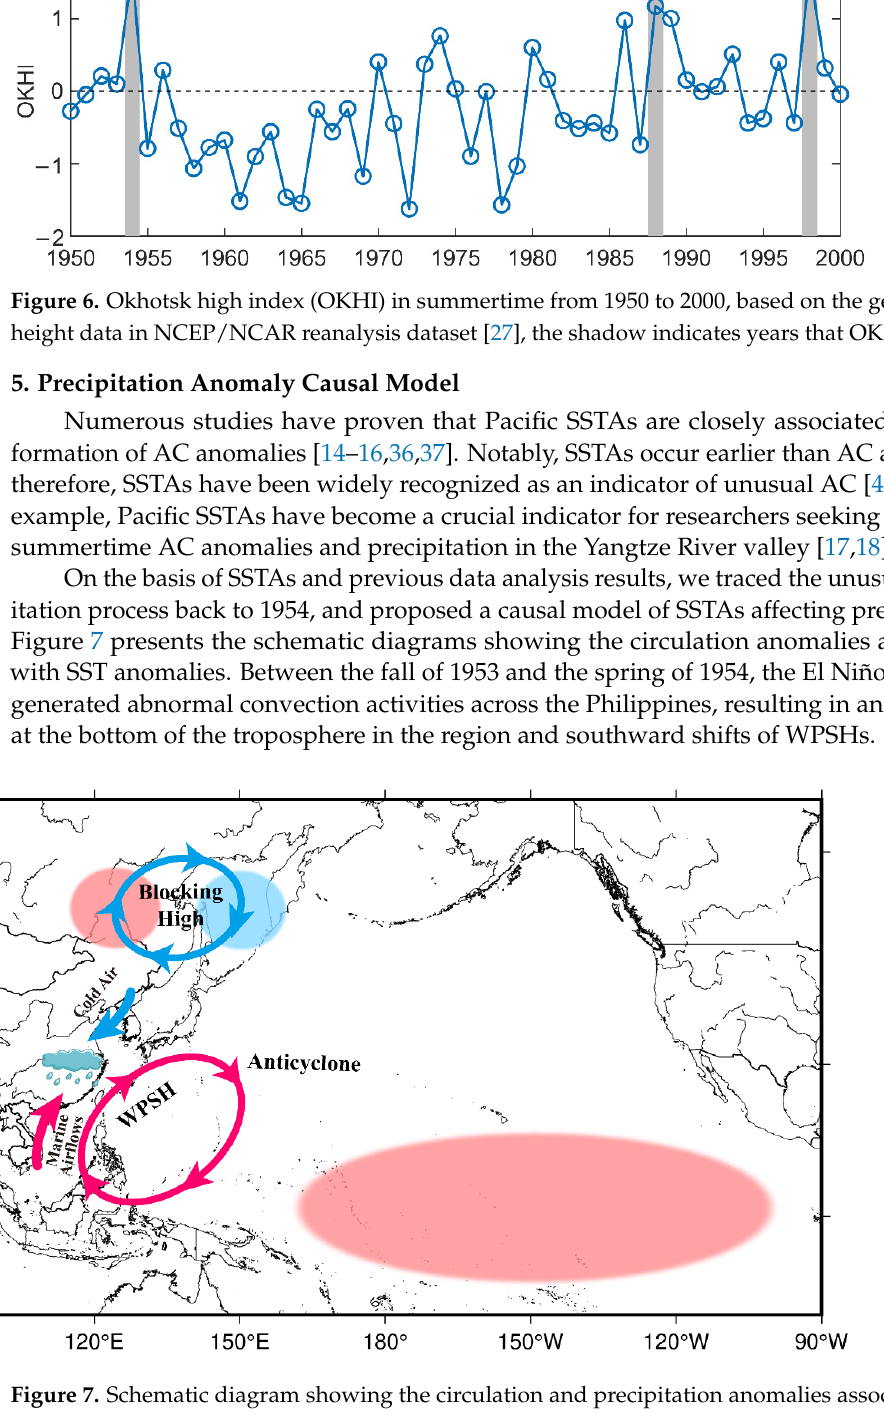
Figure 7. Schematic diagram showing the circulation and precipitation anomalies associated with SST anomalies. WPSH—western Pacific subtropical high.